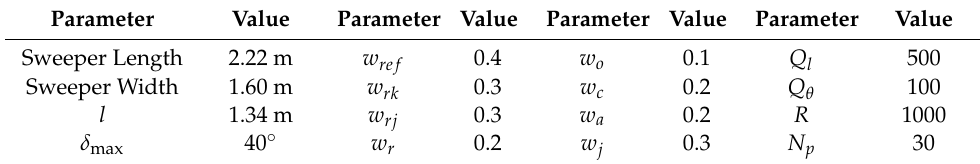
Figure 6. Autonomous sweeper. And key parameters are listed in Table 1. Table 1. Key parameters .